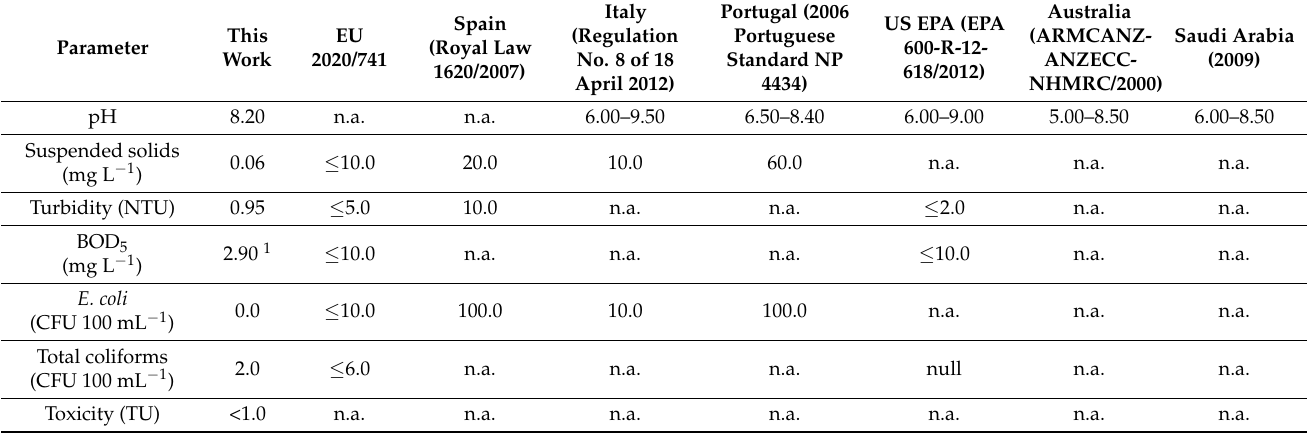
Table 8. Minimum quality requirements of recycled water from WWTPs established by different state regulations for use in irrigated agricultural activities